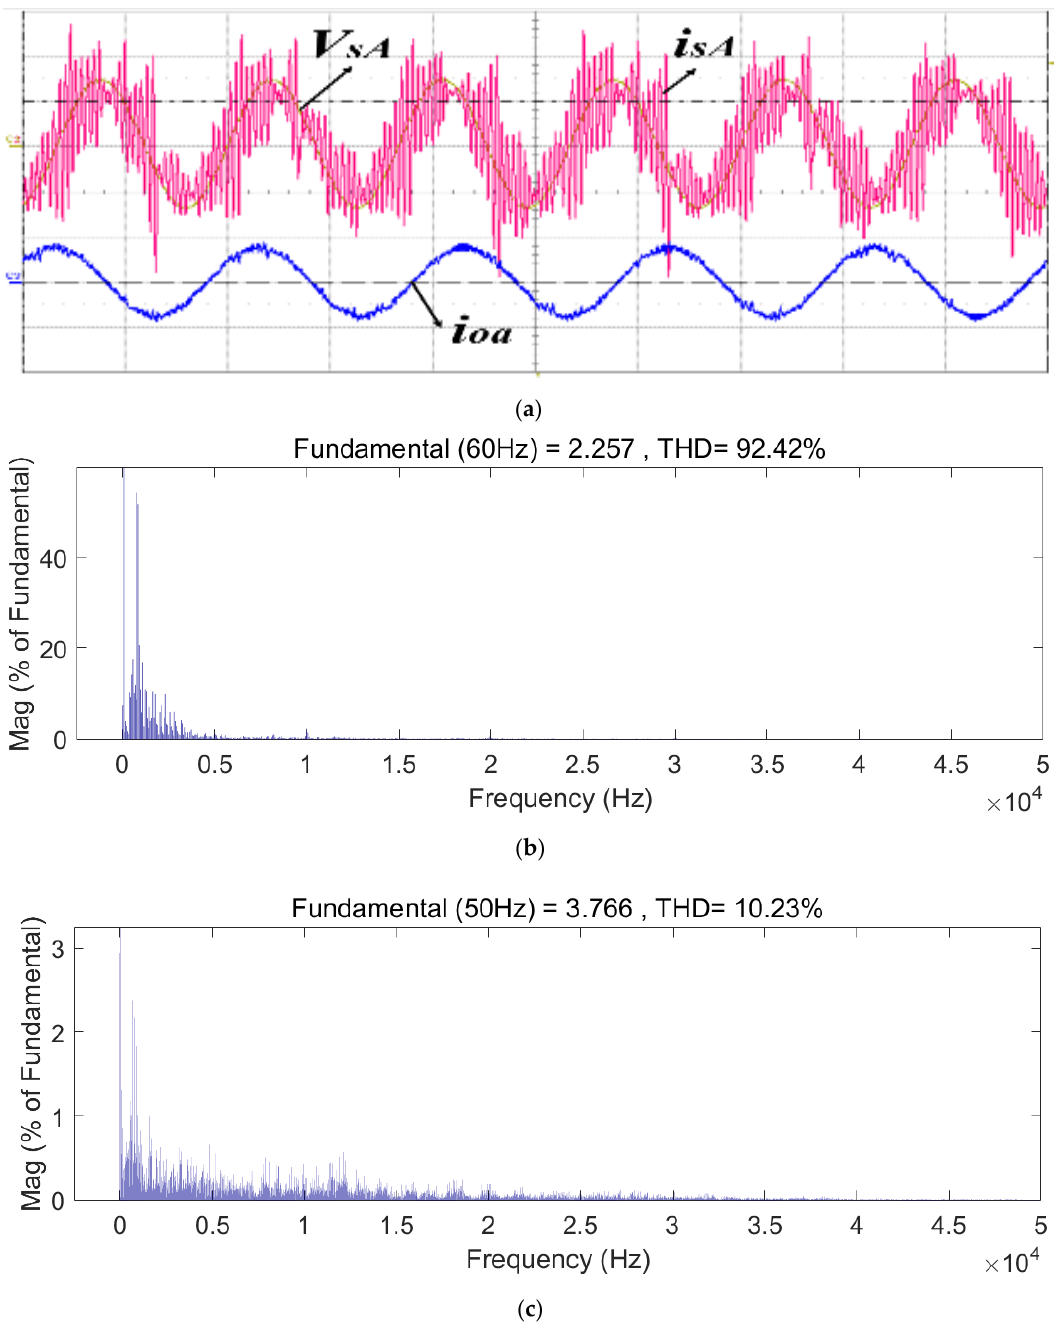
Figure 12. Experimental results of the CMPC strategy without the IFRS for the TSMC, where output-current reference amplitude is set to 4.3 A and output-current frequency is set to 50 Hz: ( a ) Waveforms of the source voltage 𝑉 𝑠𝐴 (100 V/div), source current 𝑖 𝑠𝐴 (5 A/div) and output current 𝑖 𝑜𝑎 (5 A/div). ( b ) Spectrum distribution of 𝑖 𝑠𝐴 . ( c ) Spectrum distribution of 𝑖 𝑜𝑎 .